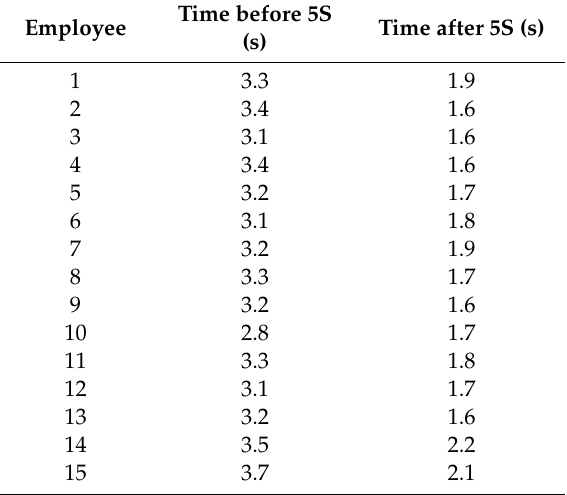
Table 7. Average times during the test before